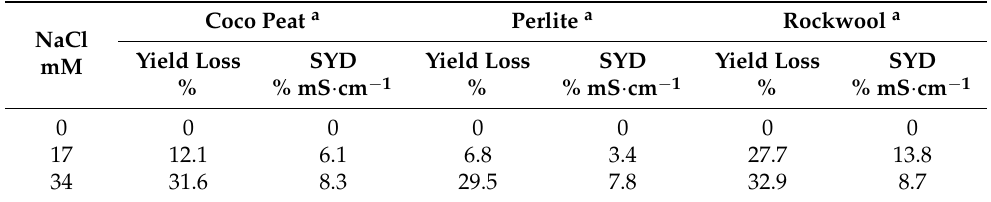
Table 1. Yield loss and salinity yield decrease (SYD) for cherry tomatoes grown in different sub- strates and salinity.